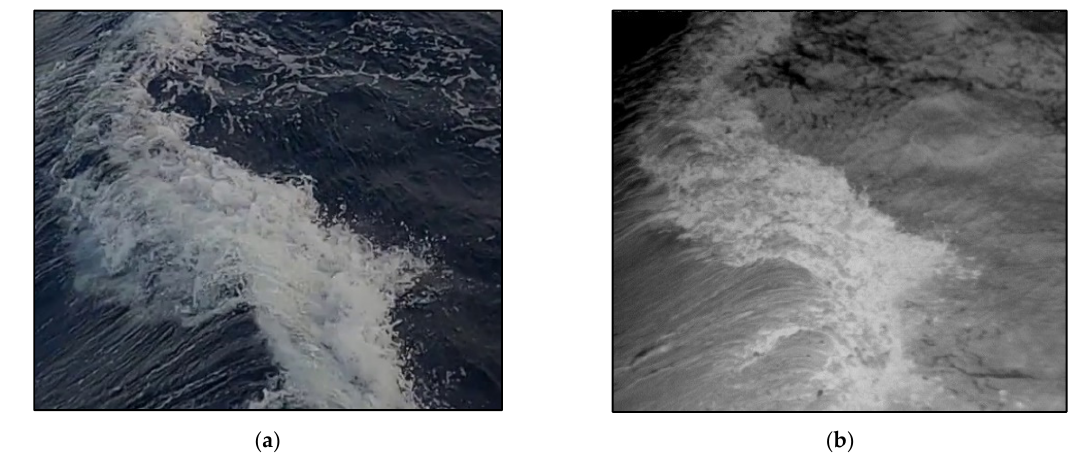
Figure 3. ( a ) Whitecaps include active and residual foams in a visible image; ( b ) whitecaps include active and residual foams in an IR image. The bright patches are active whitecaps, and the dark patches are residual whitecaps.